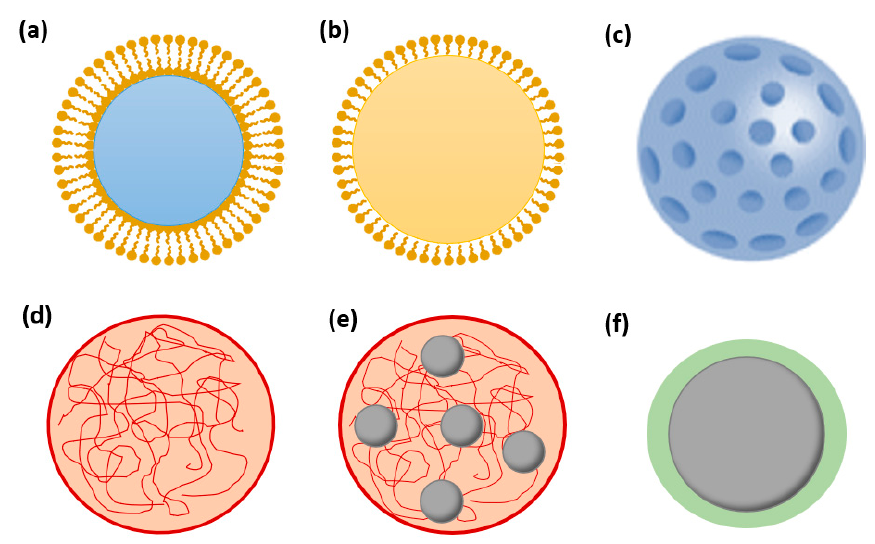
Figure 4. Schematic representation of various nanoparticles: ( a ) liposome; ( b ) lipid core nanoparticle; ( c ) ceramic nanoparticle; ( d ) polymeric nanoparticle; ( e ) superparamagnetic iron oxide NP (SPION)-loaded polymeric nanoparticle; ( f ) coated SPION. Created based on information from literature references [11–13,51,83–85].